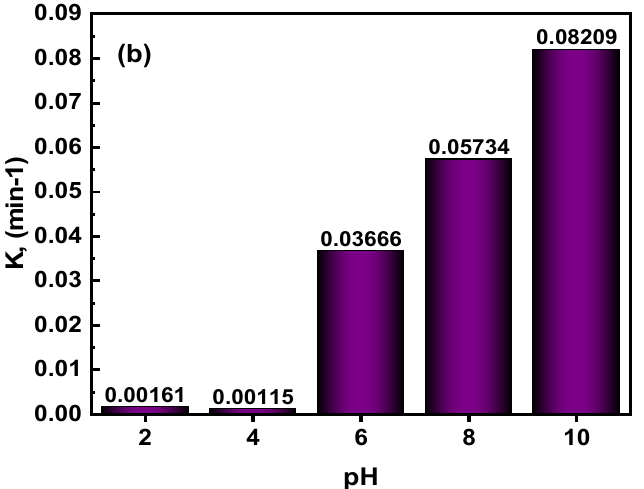
Figure 8. The different pH concentrations using 0.1 g of 7.5% Nd 2 O 3 doped CuO nanoparticle in the presence of MB dye under visible irradiation, ( a ) Kinetics ( b ) The rate constant. The result exhibited a maximum efficiency (99%) at pH 10 after 50 min from the start of irradiation (as seen in Table 4). Several techniques were utilized to calculate the pH of the CuO NPs’ point of zero charges (pH pzc ), which was between 8.5 and 9.5 [26,27]. The charge on the photocatalyst surface was positive and negative, below and above pH pzc , respectively. When the pH is less than pH pzc , repulsion between the positively charged 7.5% Nd 2 O 3 doped CuO catalyst and cationic dye reduces photodegradation efficiency [27]. Scheme 3 depicts the impact of CuO NPs’ pH pzc on cationic dye degradation. Moon- deep et al. [26] At greater pH, the CuO NP surface is charged negatively, which improves its interaction with cationic dye (VB). Meanwhile, the CuO NP surface is charged posi- tively at lower pH, enhancing its interaction with anionic dye.